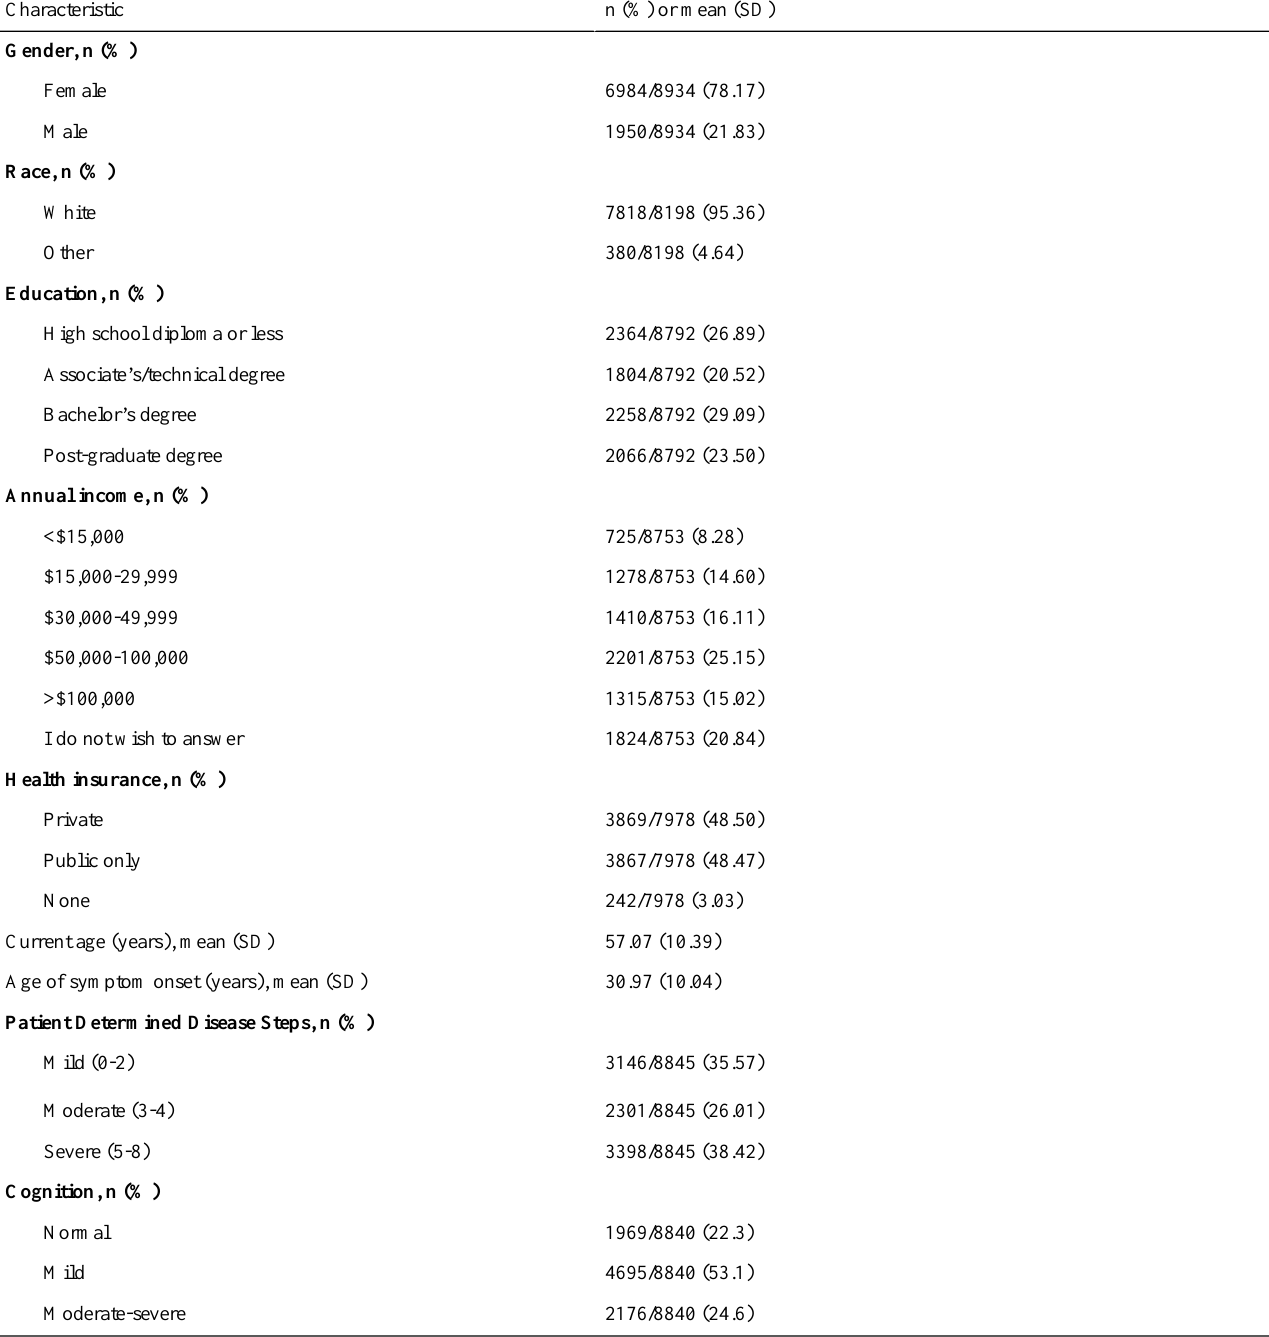
Table 1. Characteristics of eligible responders to the NARCOMS Spring 2012 Questionnaire (n=8934 a